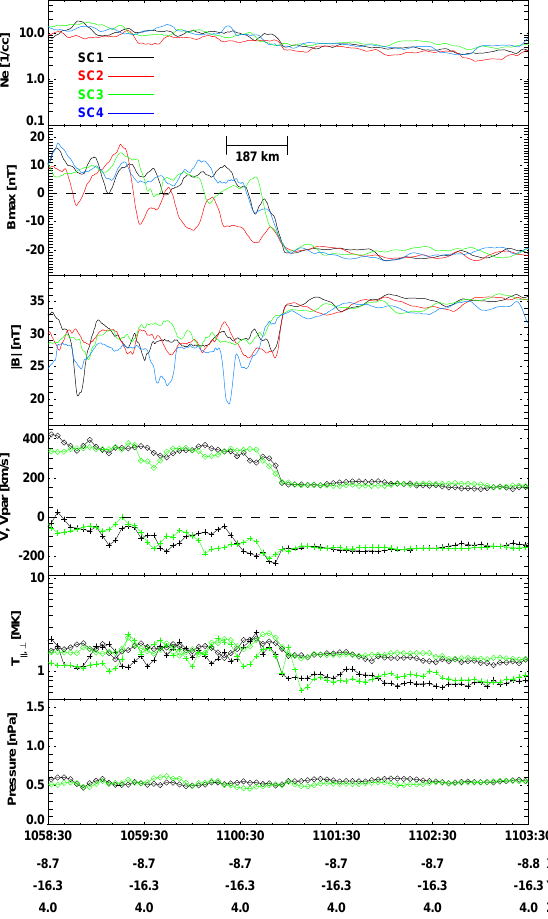
Fig. 6. Plasma and magnetic field data for the outbound crossing near 05:45 UT on 5 July 2001. Plot format and labelling as in Fig. 4. Note the pronounced plasma jetting observed by C3, directed in the − B direction ( V || < 0) which is not observed by C1 (4th panel).